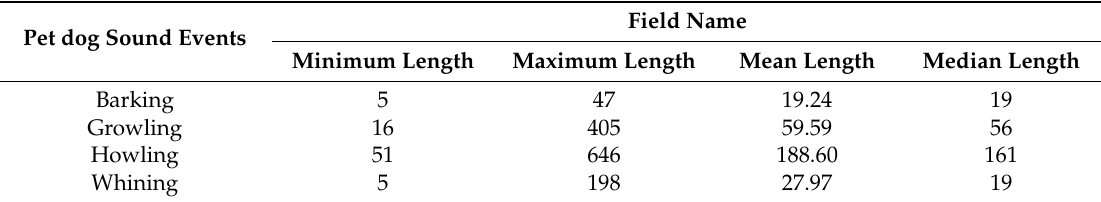
Table 3. The minimum, maximum, mean, and median lengths of the intensity data for each sound events.